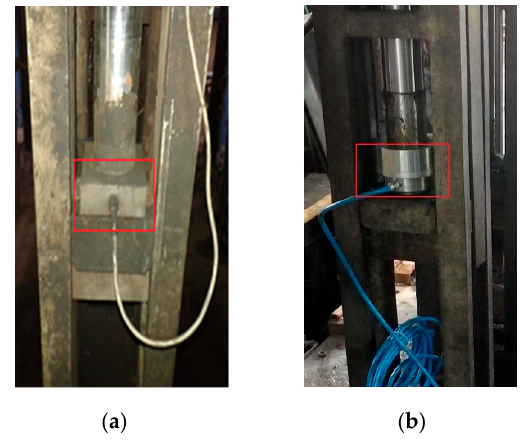
Figure 18. Installation situation. ( a ) Universal pressure sensor; ( b ) Acoustic filtering sensor.